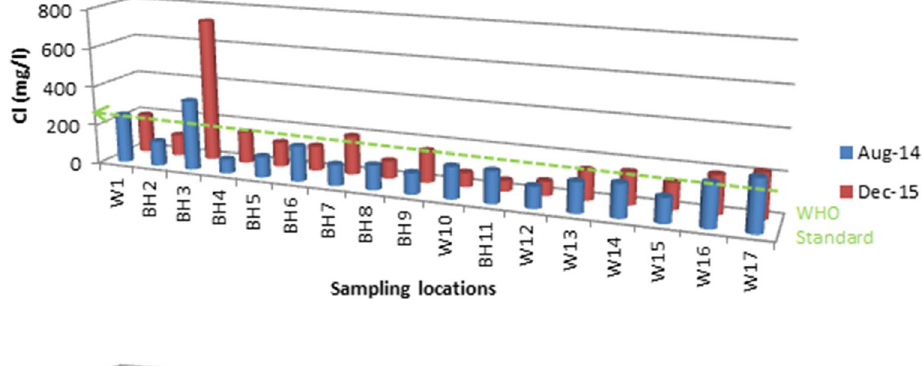
Fig. 12 Seasonal variations in N0 3 concentration of water sample versus WHO standard around the Olusosun